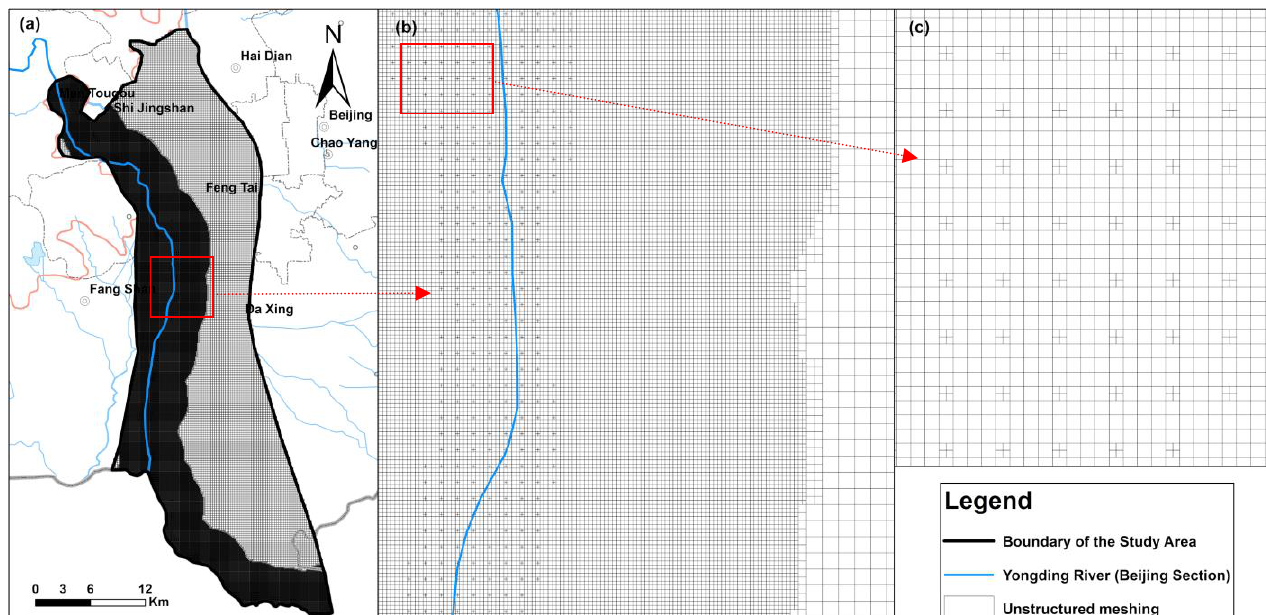
Figure 5. ( a ) Model quadtree grids division diagram. ( b ) Schematic diagram of a partial enlargement of the first-level encryption in a 3 km range along the Yongding River. ( c ) Schematic diagram of partial enlargement of secondary intensification of ecological water injection wells.